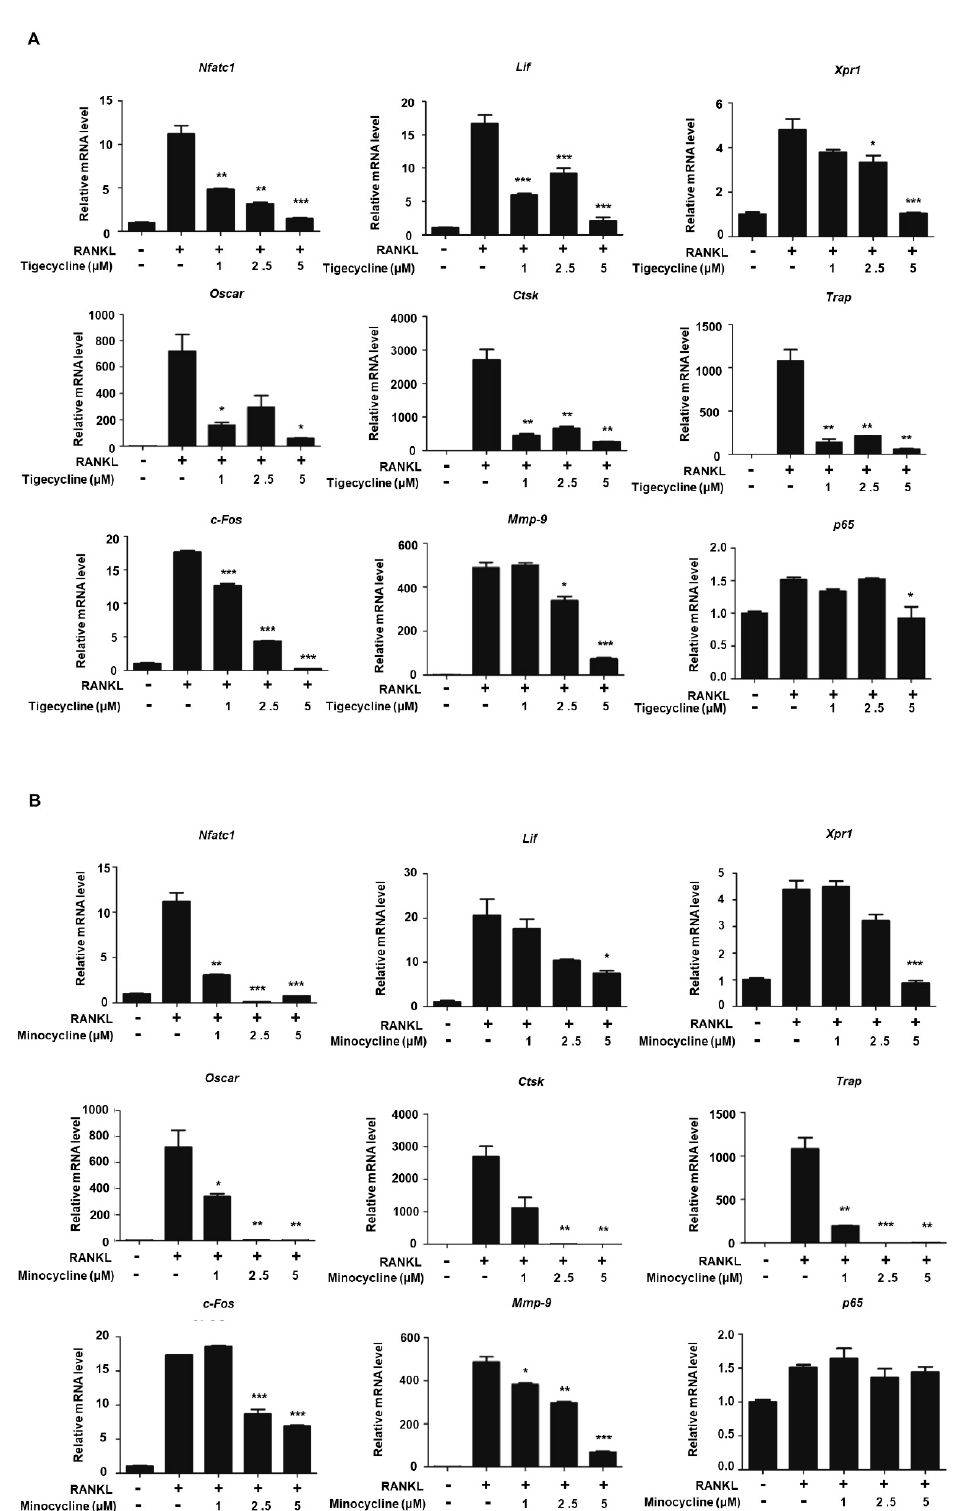
Figure 3. E ff ects of tigecycline and minocycline on the expression of osteoclast-related genes. ( A , B ) BMMs were treated with M-CSF and RANKL in the absence or presence of tigecycline or minocycline, as in Figure 2A. Total RNA was prepared from cells, and the expression levels of the nine osteoclast-related genes, as indicated, were assessed by qRT-PCR. Results represents the means ± SD of three independent experiments. * p < 0.05, ** p < 0.001, *** p < 0.0001 versus only RANKL treatment.